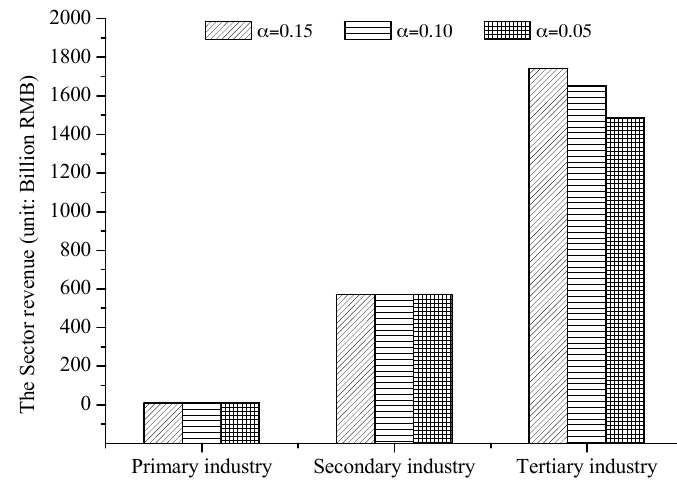
Figure 9. The different sector revenues under different violating constraints. Table 8. The benefit of each water-use department in the whole horizon.